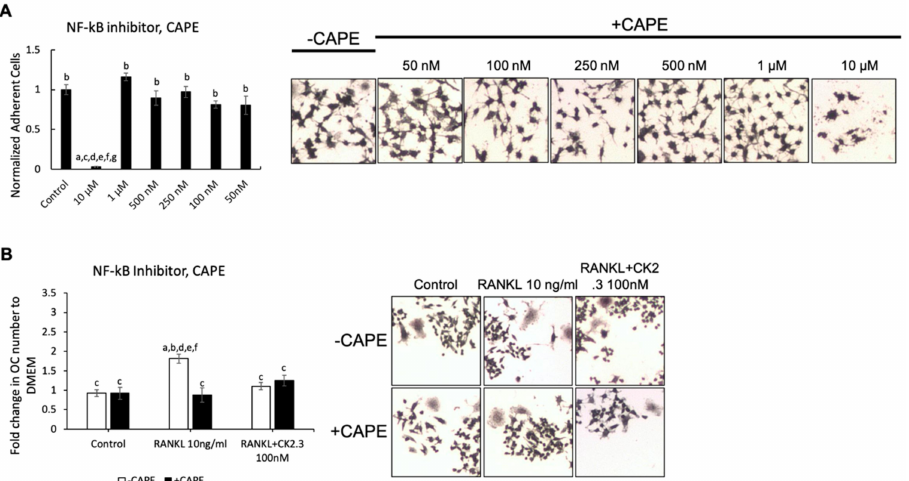
Figure 5. NF- κ B inhibitor, ca ff eic acid phenethyl ester (CAPE), did not a ff ect the antagonistic e ff ect of CK2.3 on RANKL-induced osteoclastogenesis. ( A ) Concentration curve for CAPE to determine the working concentration. a: denotes significant di ff erence from Control, b: denotes significant di ff erence from 10 µ M, c: denotes significant di ff erence from 1 µ M, d: denotes significant di ff erence from 500 nM, e: denotes significant di ff erence from 250 nM, f: denotes significant di ff erence from 100 nM, and g: denotes significant di ff erence from 50 nM. ( B ) The e ff ect of CAPE on the antagonistic e ff ect of CK2.3 on RANKL-induced osteoclastogenesis. a: denotes significant di ff erence from Control without inhibitor, b: denotes significant di ff erence from Control with inhibitor, c: denotes significant di ff erence from RANKL at 10 ng / mL without inhibitor, d: denotes significant di ff erence from RANKL at 10 ng / mL with inhibitor, and e: denotes significant di ff erence from RANKL + CK2.3 at 100 nM without